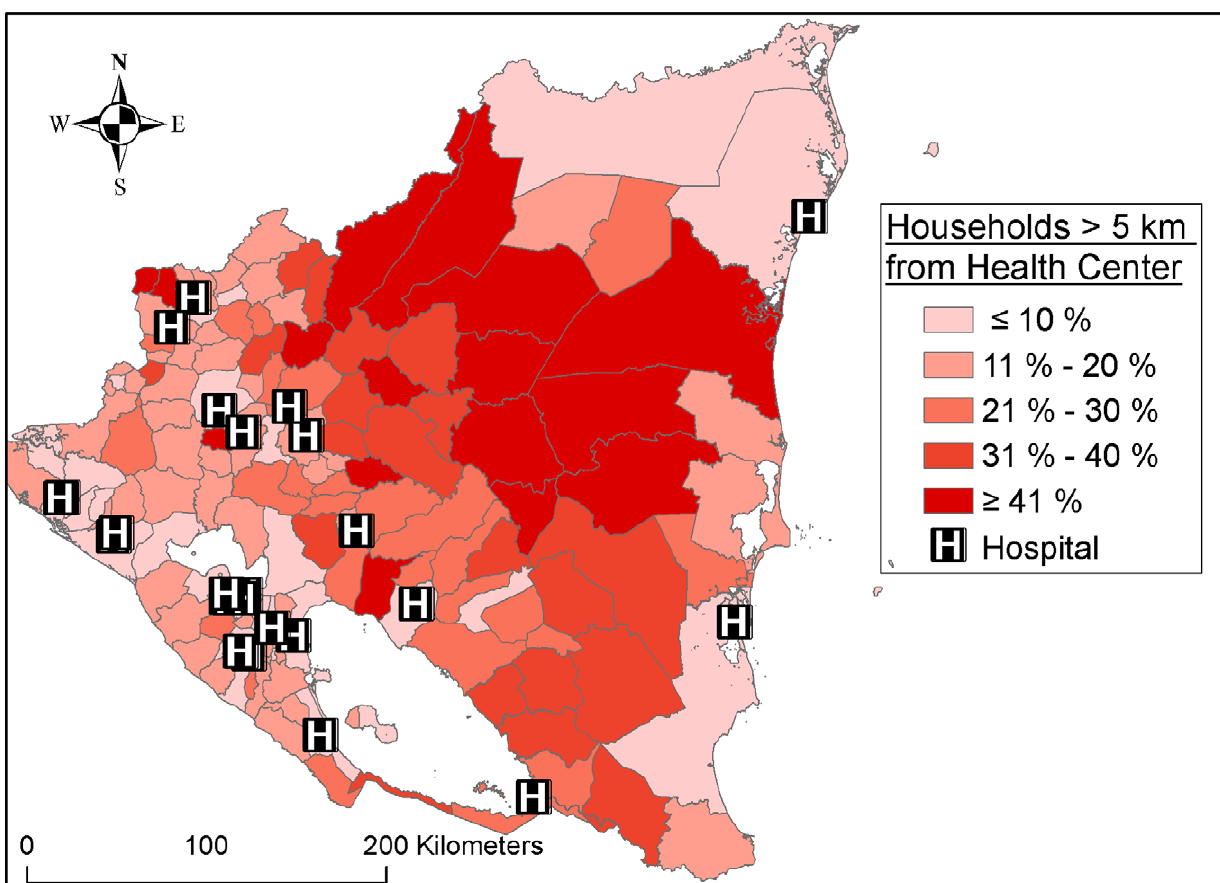
Figure 1. Distribution of hospitals and health centres in Nicaragua.